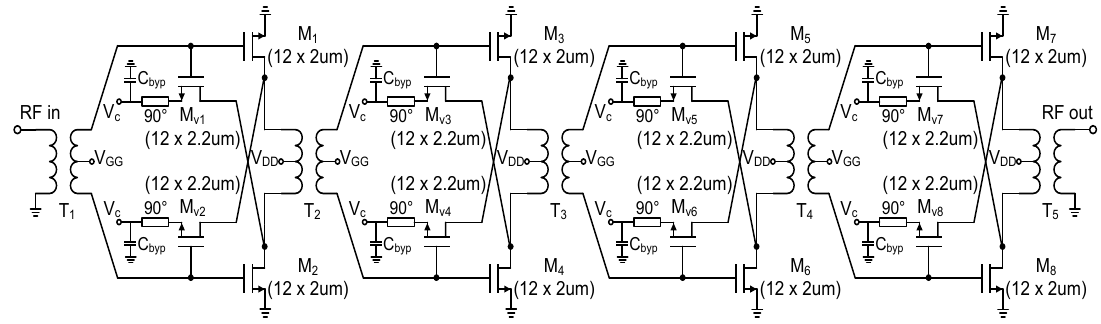
Figure 9. Complete schematic of the W-band amplifier with tunable neutralization.